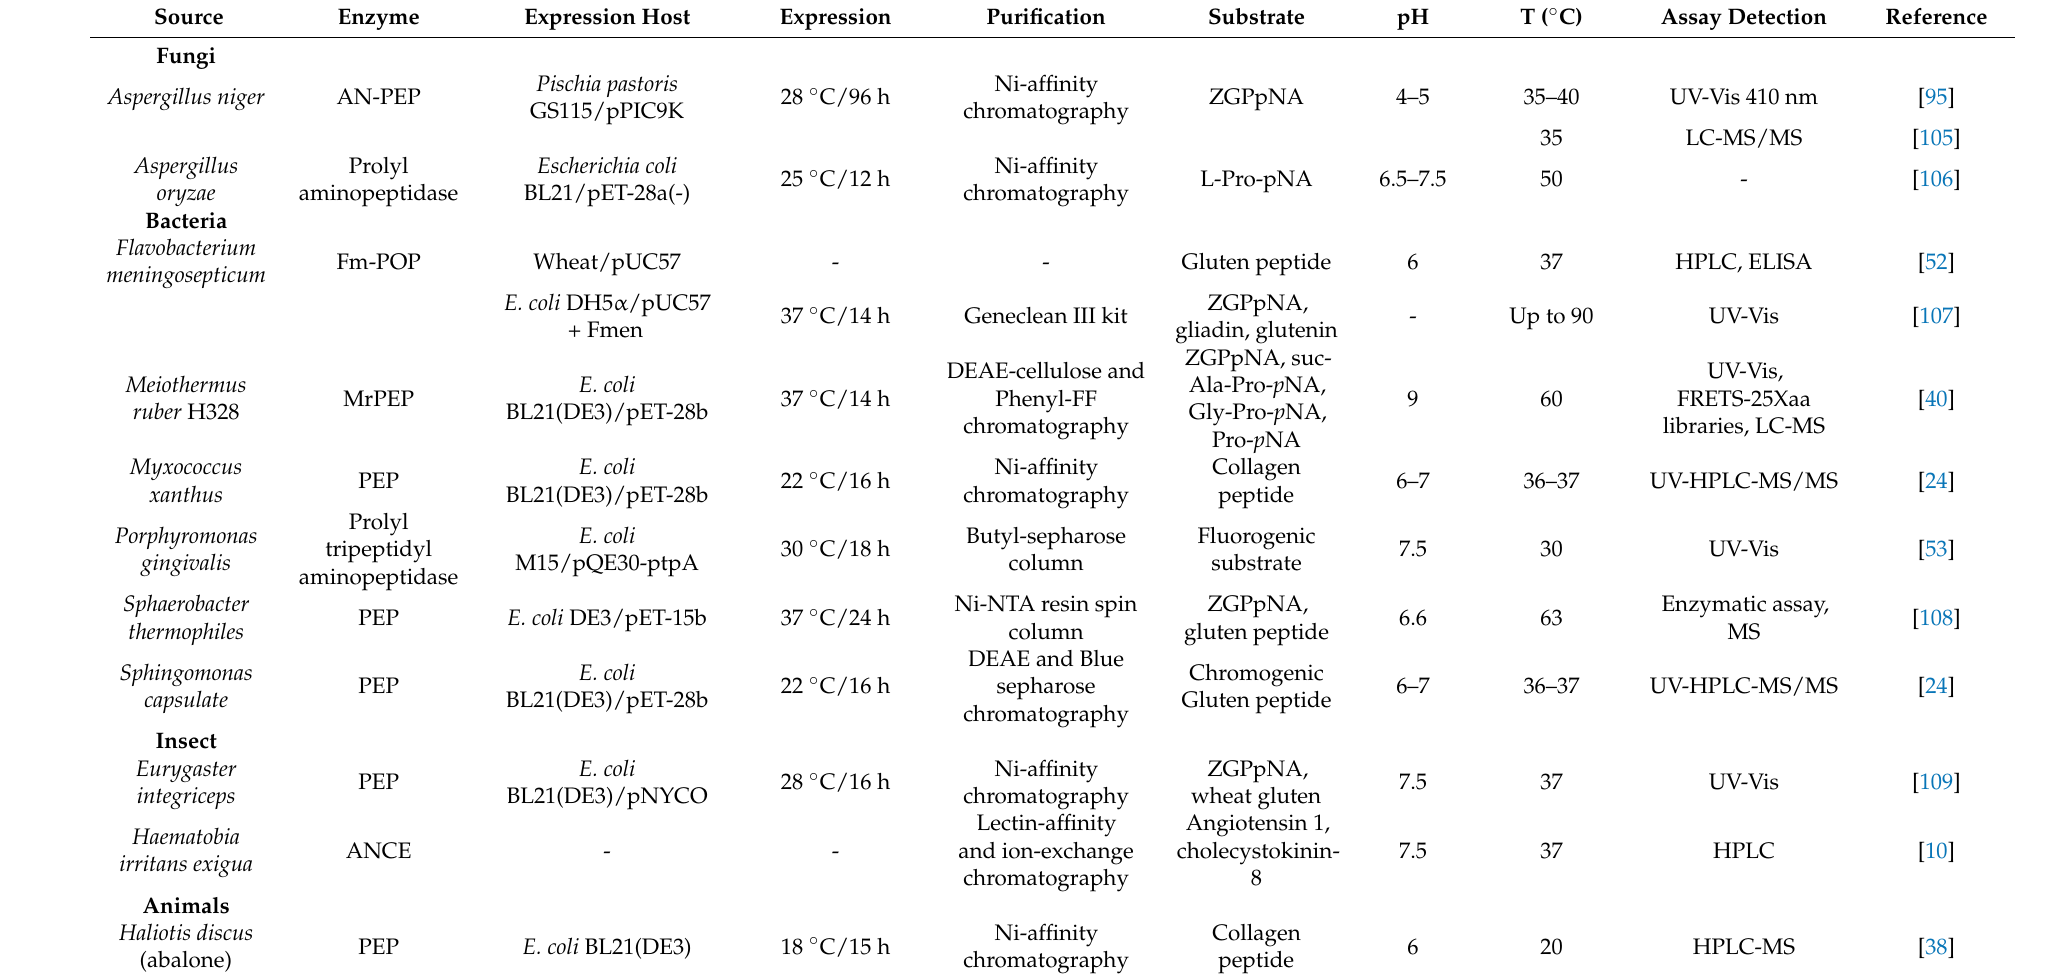
Table 4. The optimum conditions of selected recombinant PPCEs in substrate